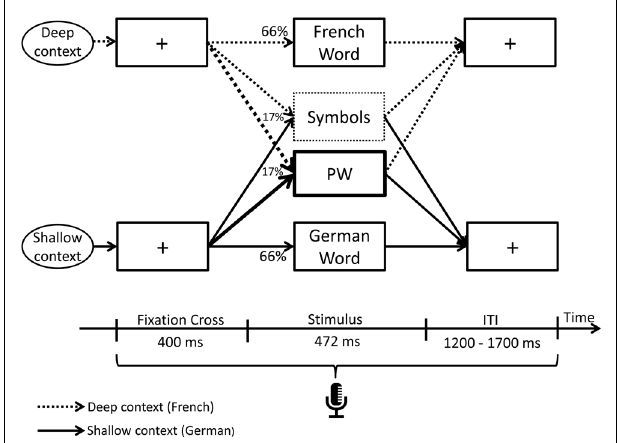
FIGURE 1 | Experimental paradigm. Each trial started with the presentation of a fixation cross of 400 ms duration, followed by a pseudo-randomly determined stimulus (66% word, 17% pseudoword, or 17% symbols) displayed for 472 ms and terminated with a response window displaying a fixation cross with a random duration between 1200 and 1700 ms. Production latencies were recorded throughout each trial. Target stimuli of the study were pseudowords (PWs).To manipulate the orthographic depth of reading, the same PWs were embedded among two separated language context sessions: in the deep orthographic context, the words consisted of French and in the shallow orthographic context of German words.The order of language context sessions was randomized across